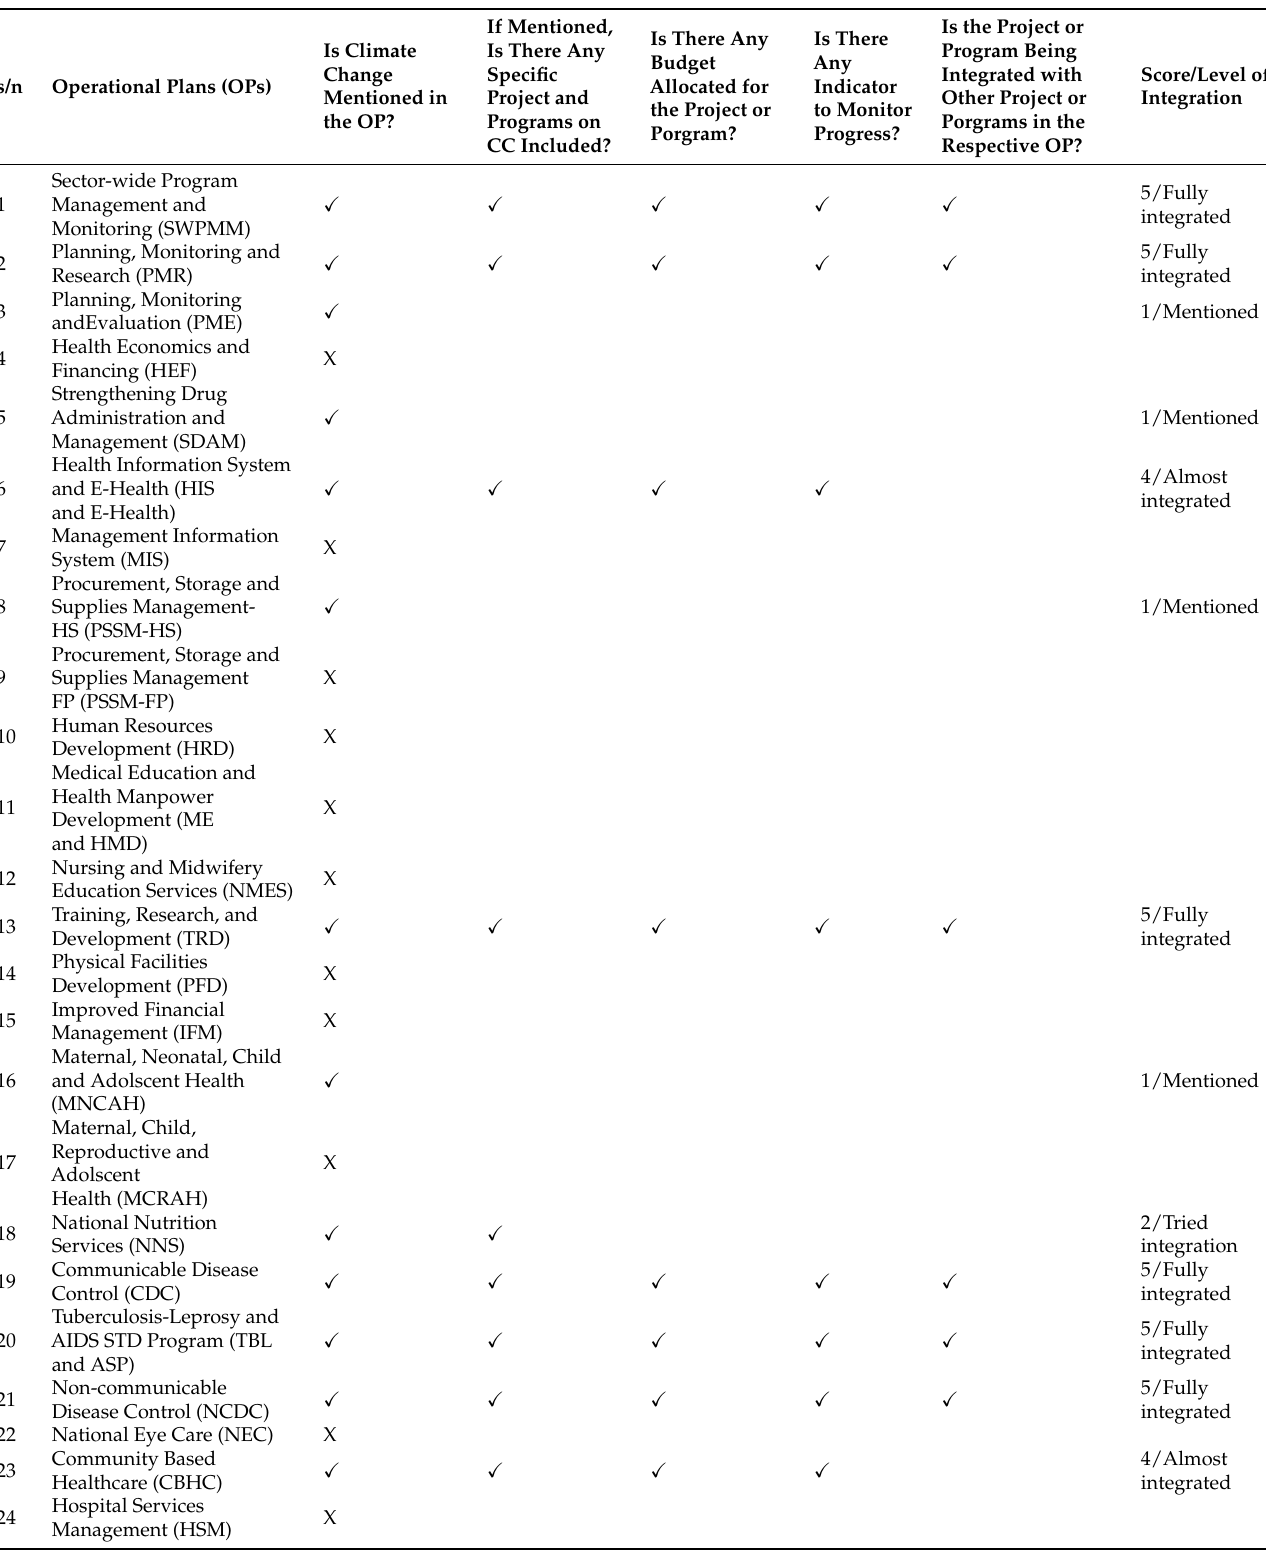
Table A3. Assessment of climate change integration status in 4th HPNSP Operational